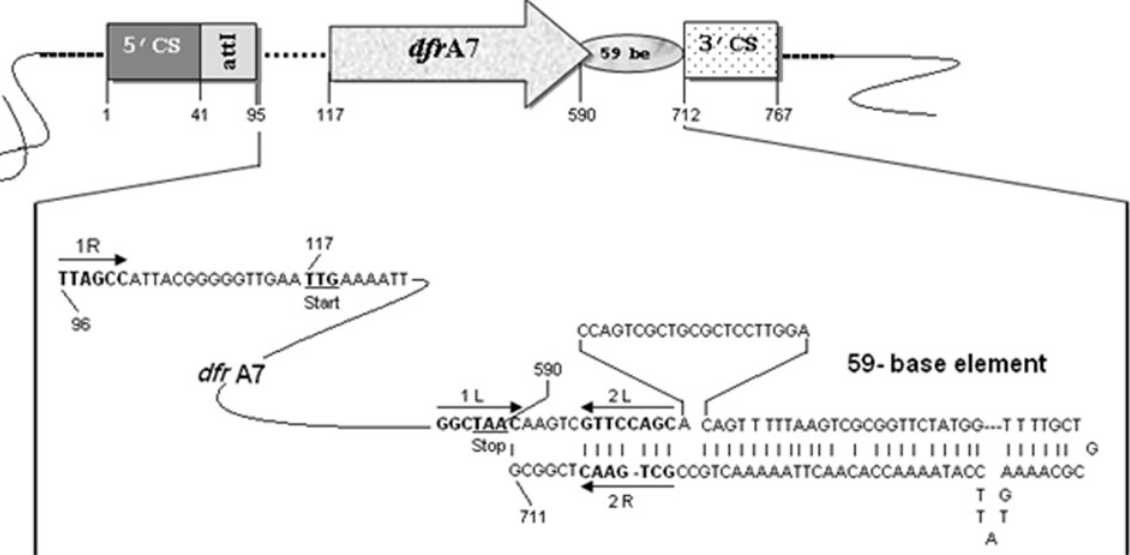
Fig 3. Diagram of amplified class 1 integron. Schematic representation of class 1 integron amplicon of the strain PGB01 amplified with the Int 2 F-3 0 CS primer pair. Numbers correspond to sequence positions in EMBL Ac. No. FN563072.